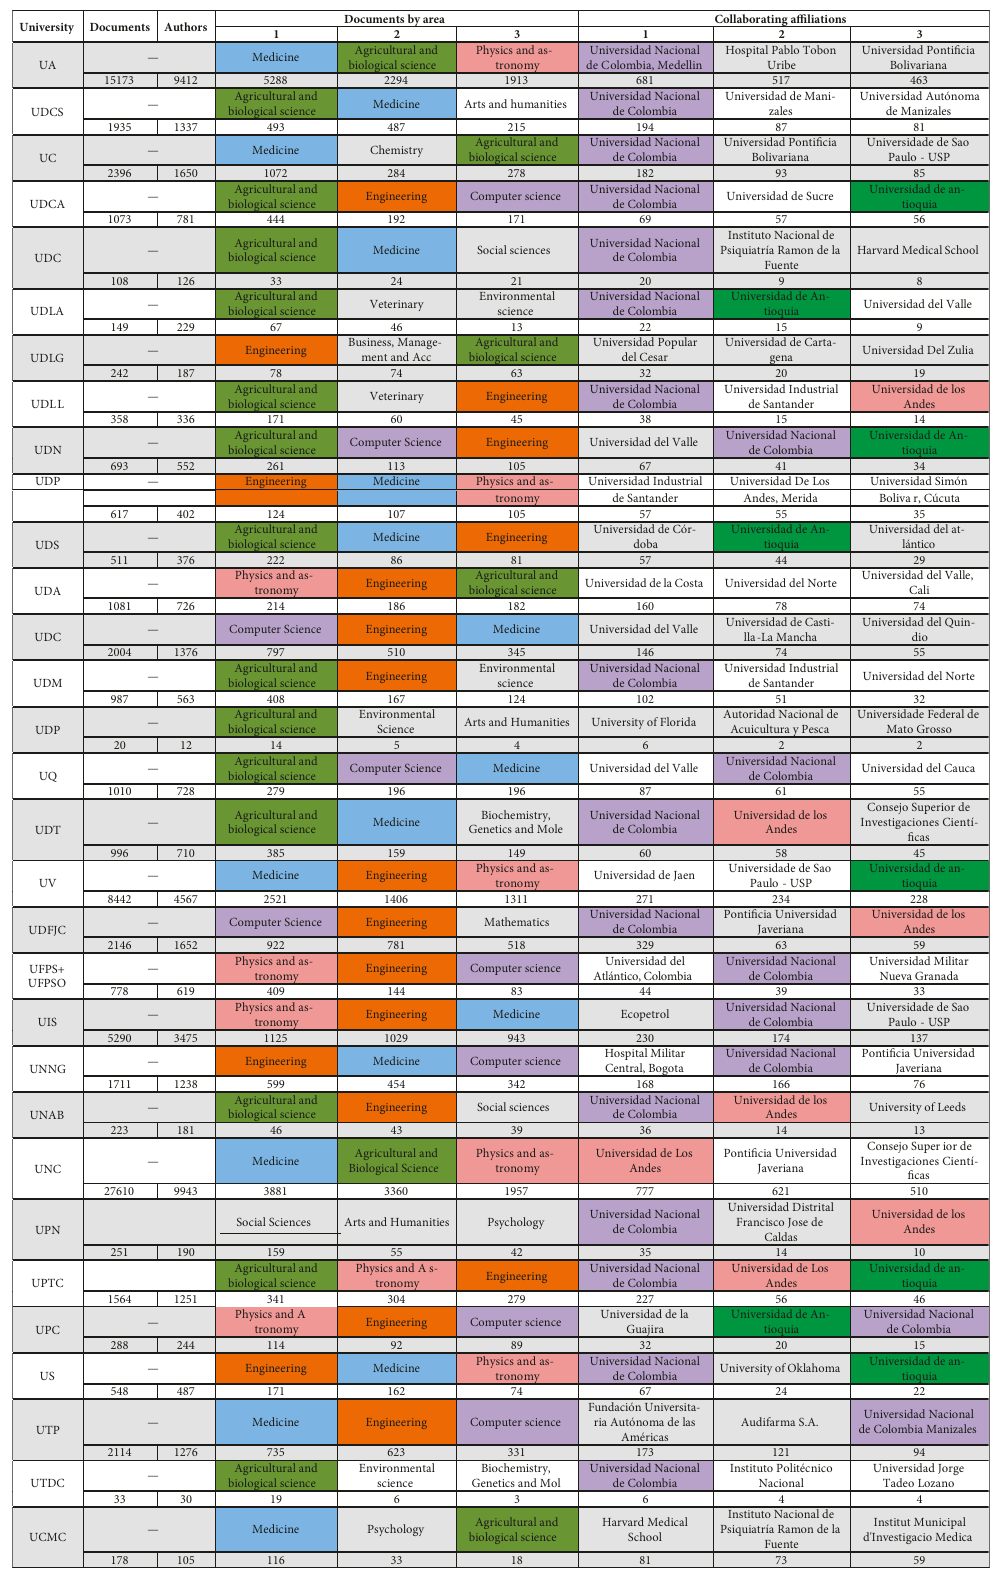
Table 3: Summarization of the documents by area and collaborating